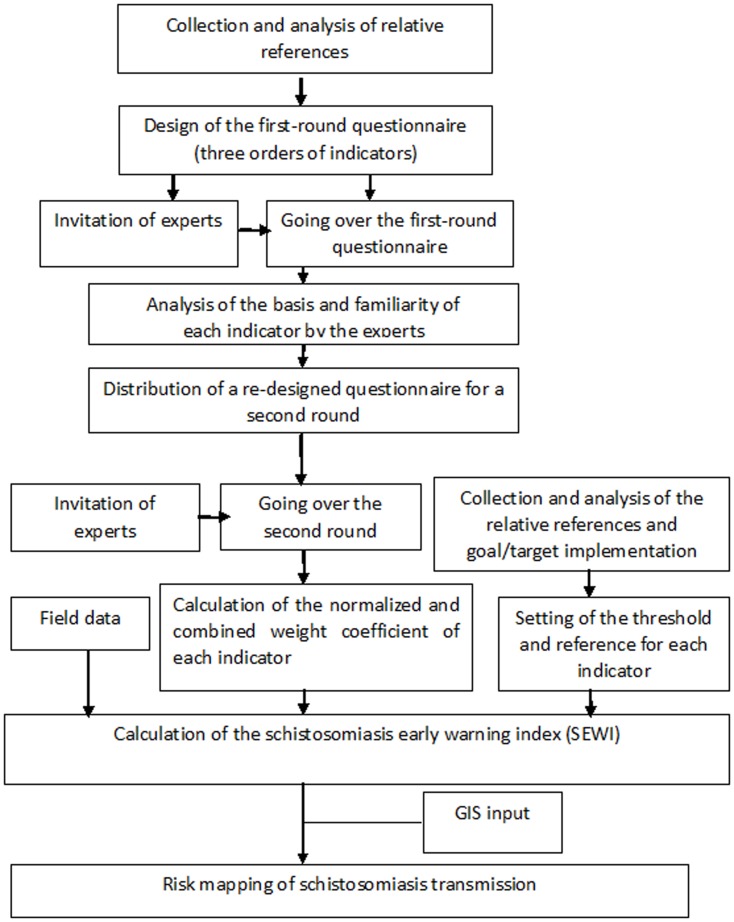
The framework of the whole study in Jiangsu Province, China.